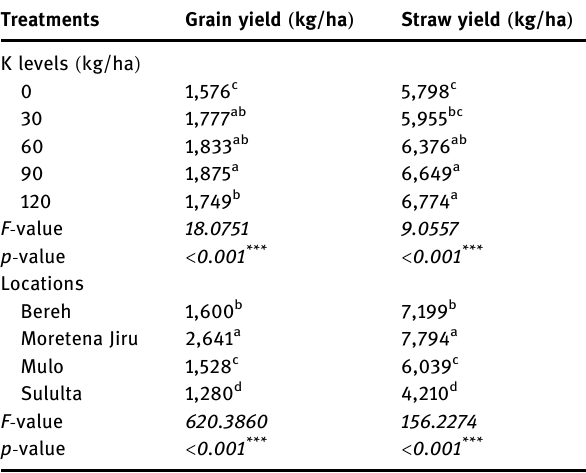
Table 2: The e ff ect of potassium fertilizer levels and location on te ff grain and straw yields in the central highlands of Ethiopia